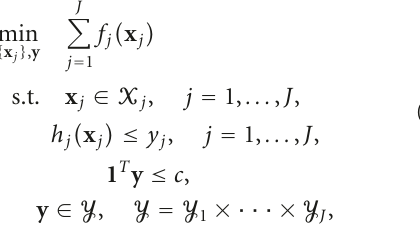
method is depicted in Figure 3. The algorithm starts with μ 0 = 0 and iterates as follows: dual subproblems → primal projection → primal subproblems → dual projection → dual